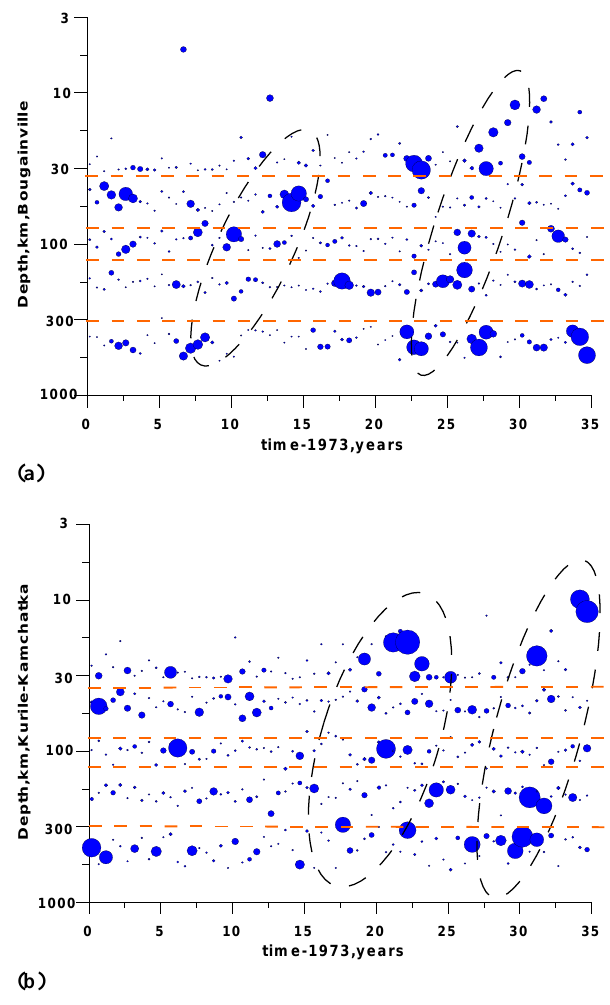
Fig 3b. Depth-time (d, t) diagram for Kurile-Kamchatka zone. Notations are the same as in Fig.3a. Fig. 3. (a) Depth-time ( d , t ) diagram of the seismic variability indices for Bougainville zone. Bubble size is proportional to e c (t k ,d k ,j) value. Possible packets are outlined by dashed ovals. Boundaries of the 5layers are shown by dotted lines. (b) Depth- time ( d , t ) diagram for Kurile-Kamchatka zone. Notations are the same as in (a)